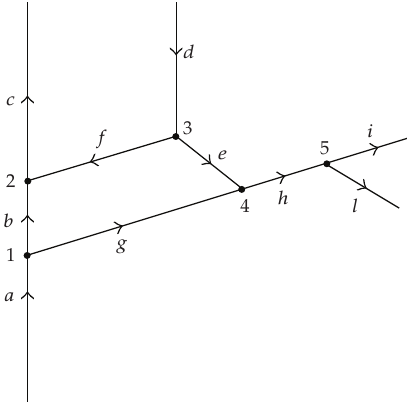
Figure 8: Topology of the portion of the real urban network of Salerno.